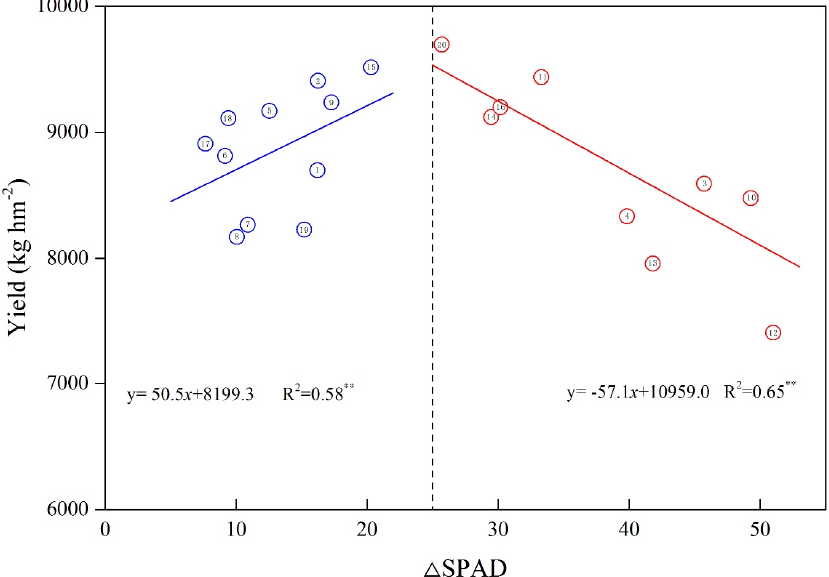
Figure 2. Relationships between the yield and SPAD difference of the 20 maize cultivars. The number in the circle represents the order of cultivar, and the name of cultivar refer to table S1.